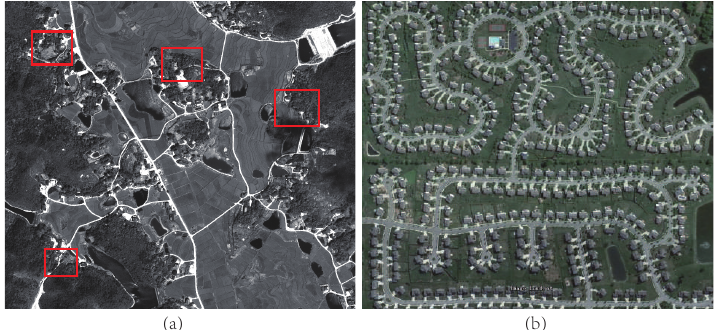
Figure 1. Comparison of the road: in rural region ( a ); and in urban region ( b ). The red boxes in ( a ) indicate some abnormal spectral road regions, where are challenging for road